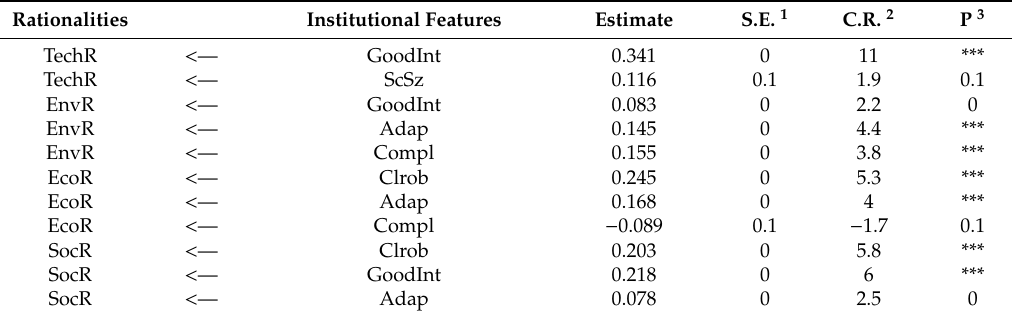
Table 4. Institutional features and rationalities (Pathways